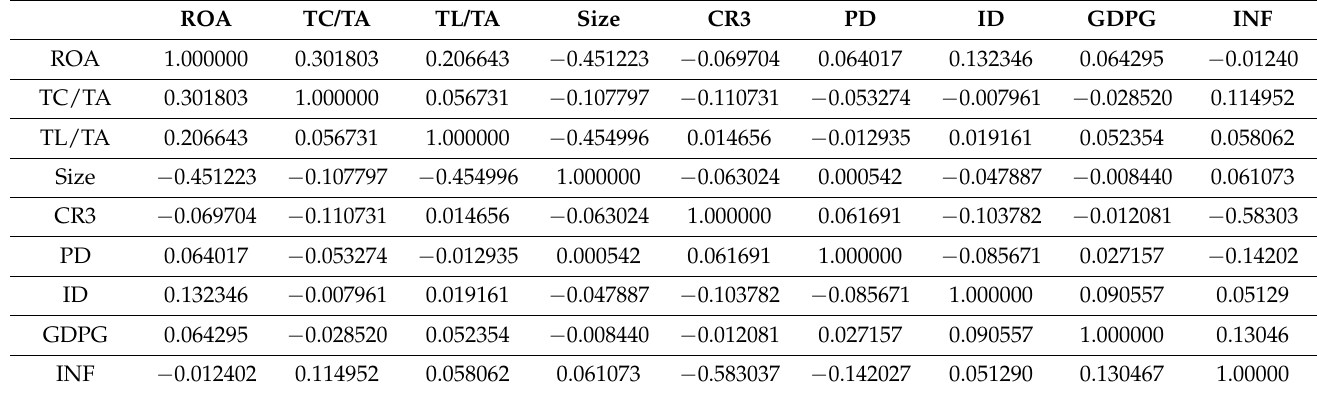
Table A1. Correlation matrix for the ROA model.